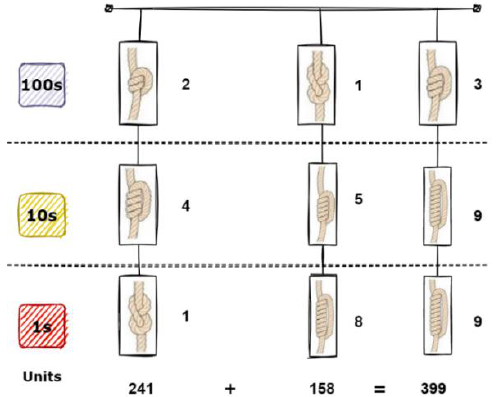
Figure 5. A knots example of numbers from one to nine.